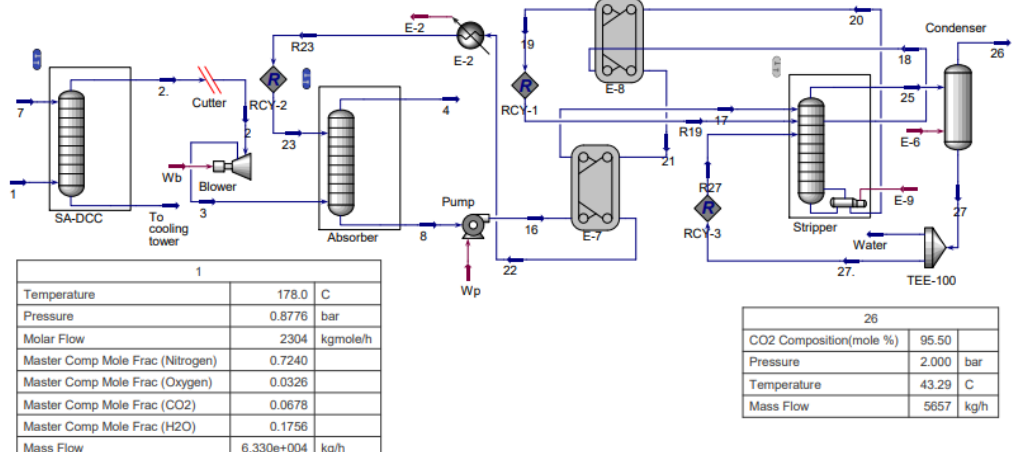
Figure 3. Schematic of the simulated plant by Aspen HYSYS ® .